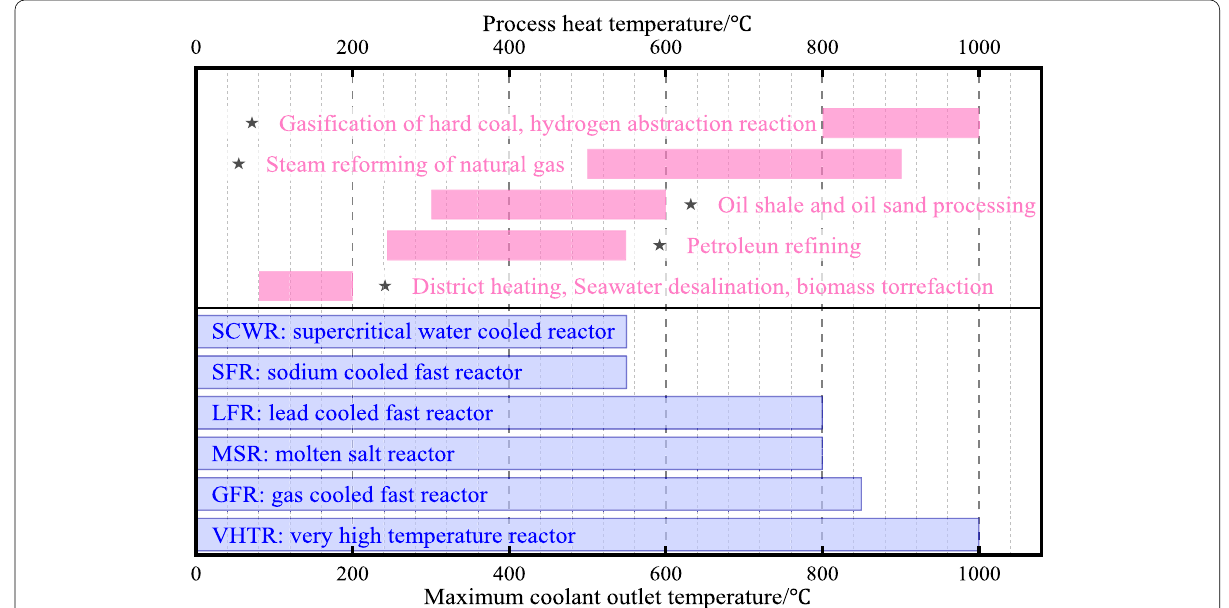
Fig. 2 Maximum coolant outlet temperature of Generation IV reactor and process with temperature range